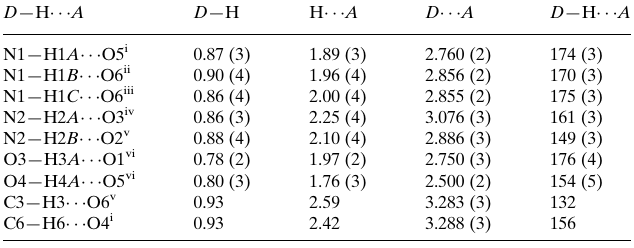
Hydrogen-bond geometry (A˚ , (cid:4)